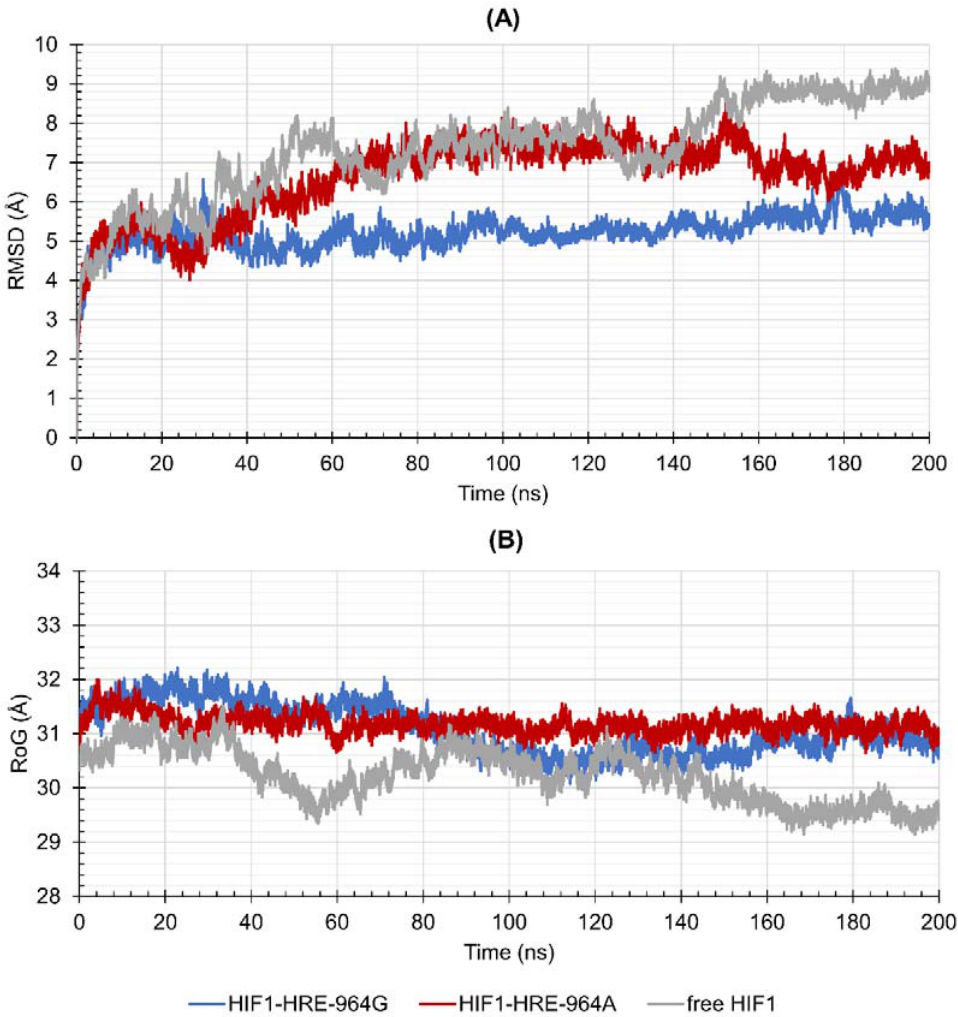
Figure 4. Values of ( A ) Root Mean Square Deviation (RMSD) and ( B ) Radii of Gyration (RoG) over 200 ns for the HIF1 transcription factor (HIF1a-ARNT) bound to the HRE according to the HLA-G − 964G > A polymorphism in comparison with the free HIF1. Note: Author's own image. HIF1 has higher structural stability when bound to the HRE containing the − 964G allele when compared to the protein-DNA complex exhibiting the − 964A allele. In addi- tion, the HIF1-HRE with the A allele hits RMSD values like those of the free HIF1, rein- forcing the hypothesis that HIF1 binding to HRE with the G allele is more stable. HIF1 folding did not differ between the two molecular complexes, which reached RoG values like that of the free transcription factor in the initial time; however, the free protein showed a slight compaction during the simulation, while the complexes remained un- changed, and accordingly, RoG results. RMSD and RoG for DNA were also analyzed (Fig- ure 5A,B, respectively) showing a high flexibility for the two molecular complexes.